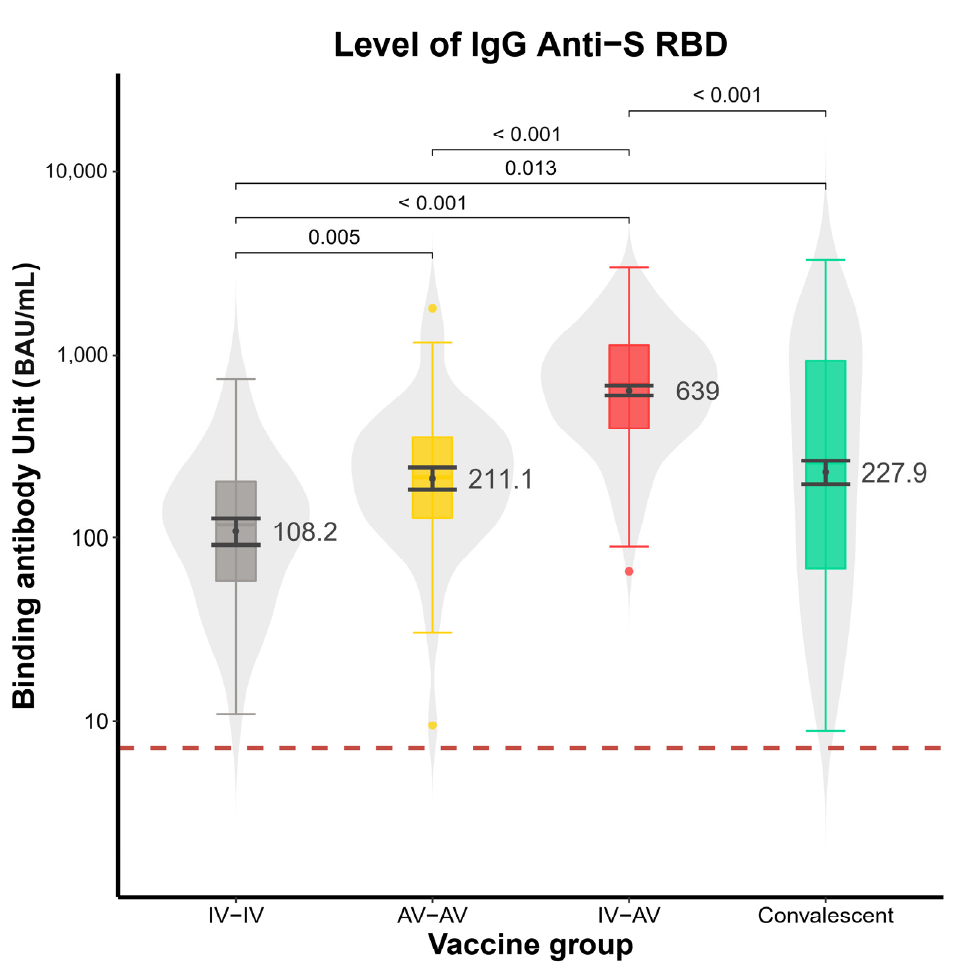
Figure 3. Violin plots of level of IgG anti-SRBD titer in 4 groups. Boxplots show geometric mean and IQRs. Serum was collected at 4 weeks. IV-AV group showed a significantly higher level ( p < 0.0001) (639 BAU/mL, 95% CI 563–726) than the AV-AV (211.1 BAU/mL, 95% CI 161–277), Conva-